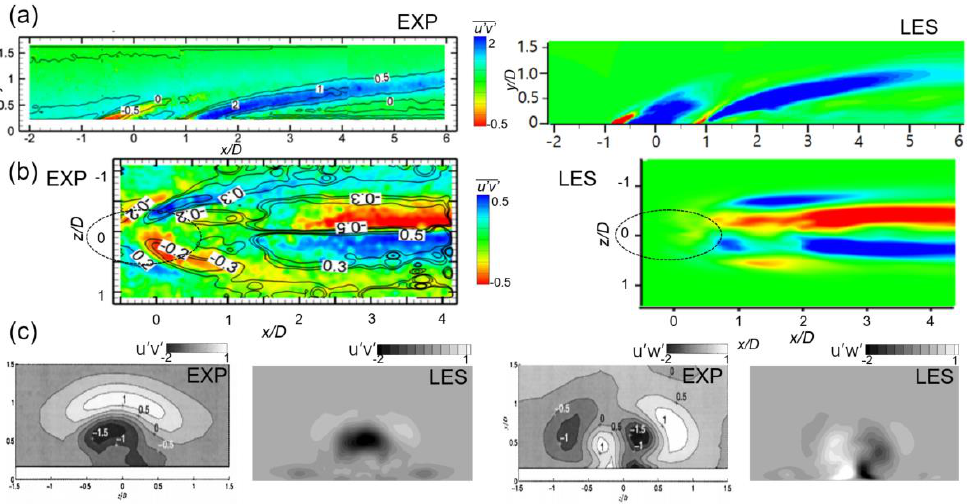
Figure 14. Reynolds stress contours [77]: ( a ) at z / D = 0, ( b ) at y / D = 0.5, and ( c ) at x / D = 2.5.